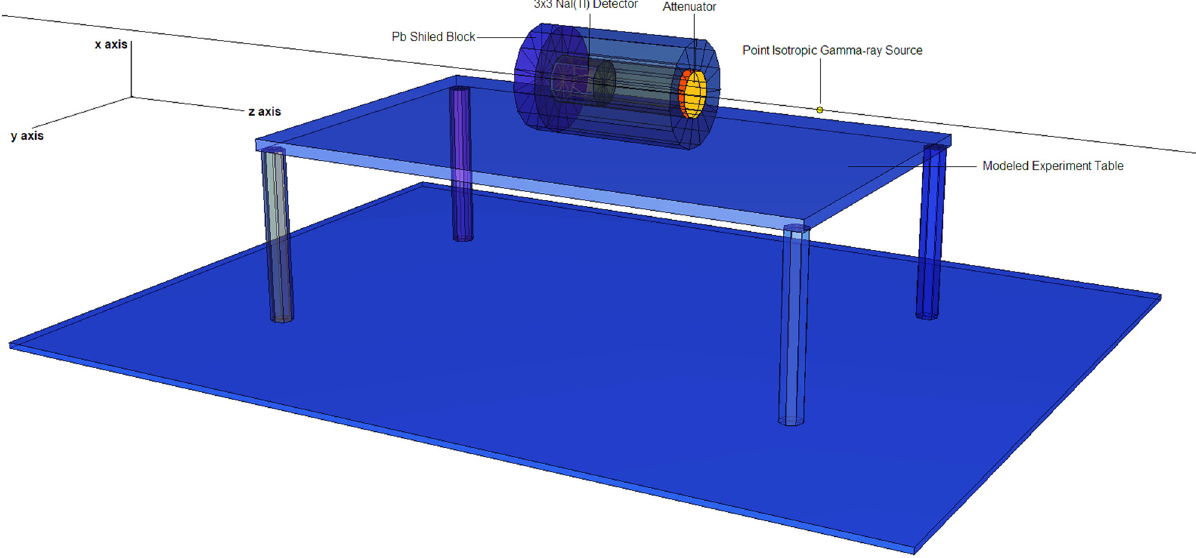
Figure 2: 3 - D view of the modelled gamma - ray transmission experiment setup of MCNPX obtained from MCNPX Visual Editor ( VE VisedX22S )